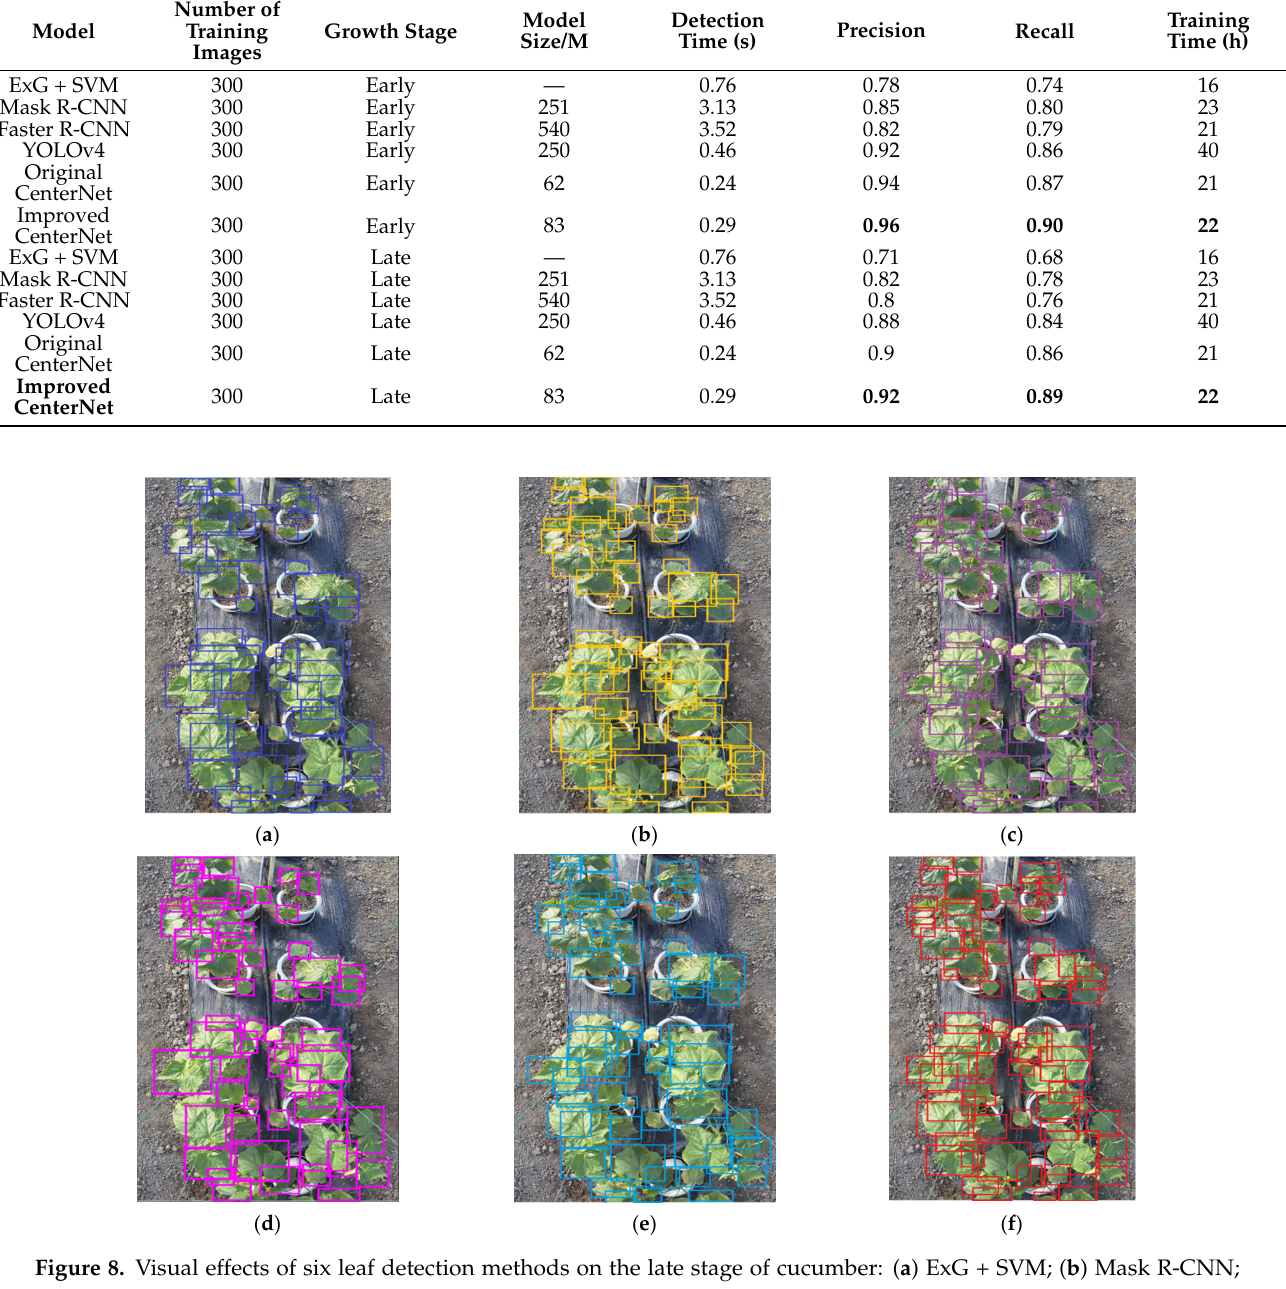
Table 1. Relevant parameters of six object detection methods in detecting cucumber leaves. Number of Train- Model Model Growth Stage ing Images Size/M Model